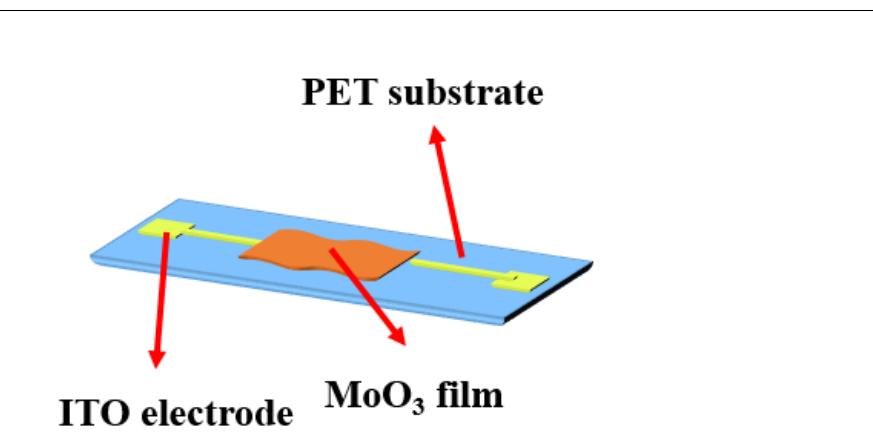
Figure 8. Schematic structure of the flexible humidity nanosensor of MoO 3 nanosheets on ITO/PET substrates.